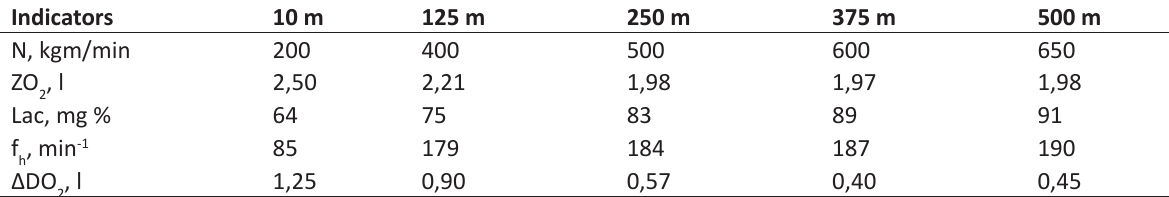
Legend: the same as in table